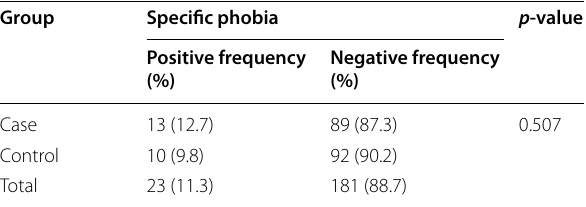
Table 3 Prevalence of specific phobia in children in the case